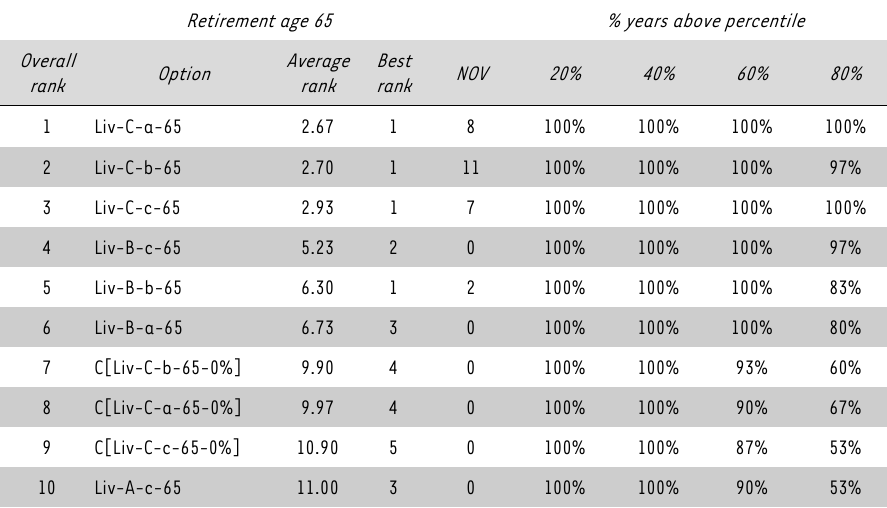
TABLE 4: All annuity strategies ranked by average rank for a male retiree aged 65 Retirement age 65 % years above